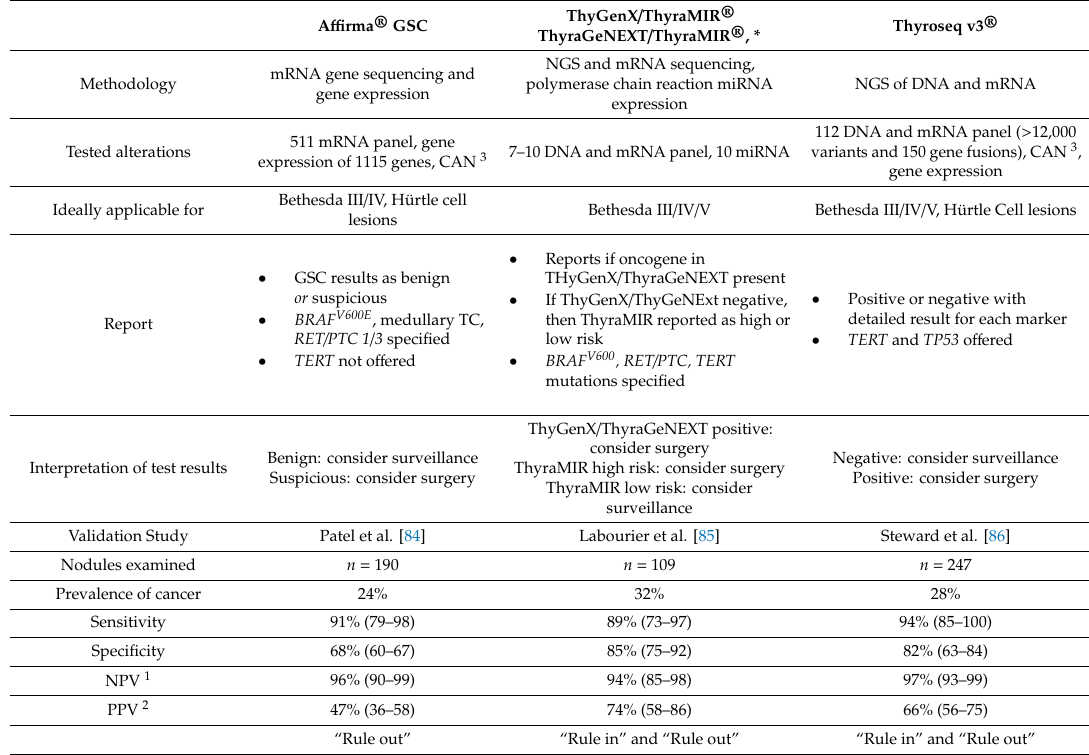
Table 2. Summary of recent commercially available molecular tests